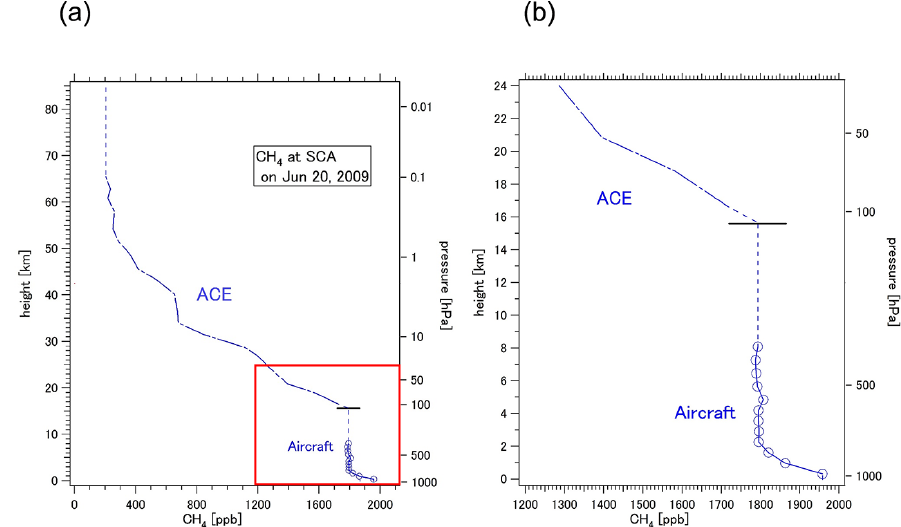
Figure 3. An example of CH 4 profiles constructed over Charleston, South Carolina (SCA), USA. (a) High-altitude profile. The red rectan- gular area is expanded in (b) . Vertical coordinate is represented by geometric height (left axis) and pressure (right axis). The blue circles represent aircraft measurements and are connected by solid lines. The horizontal black lines indicate the tropopause. The dash-dotted lines represent the profile above the tropopause based on the ACE-FTS or HALOE climatology (ACE-FTS in this case), and the dashed lines show the part of the CH 4 profile that was assumed. See Sects. 2.2.2. and 2.2.3 for more